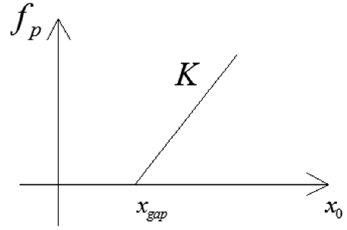
Figure 2. Force-displacement curve.